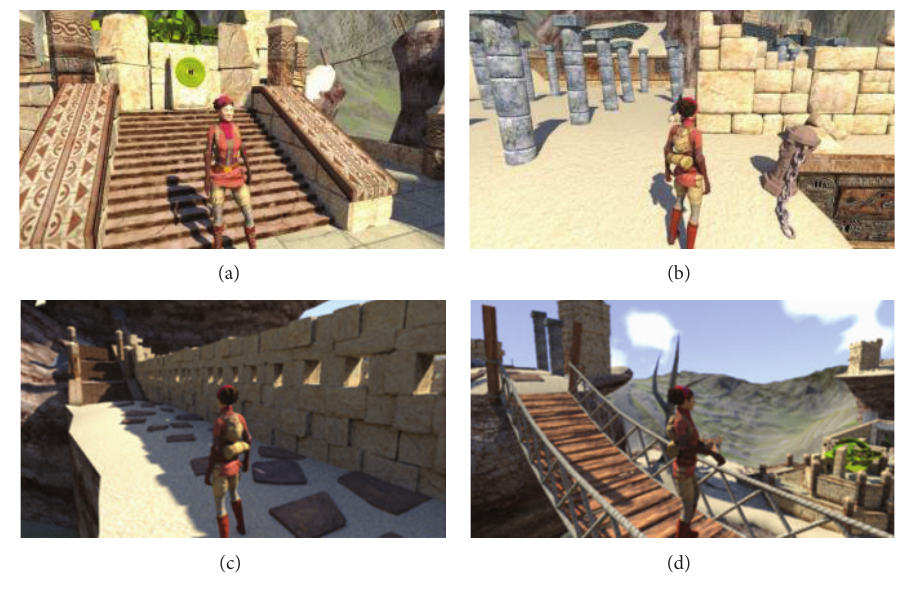
Figure 13: Four views from “It’s About Time.”